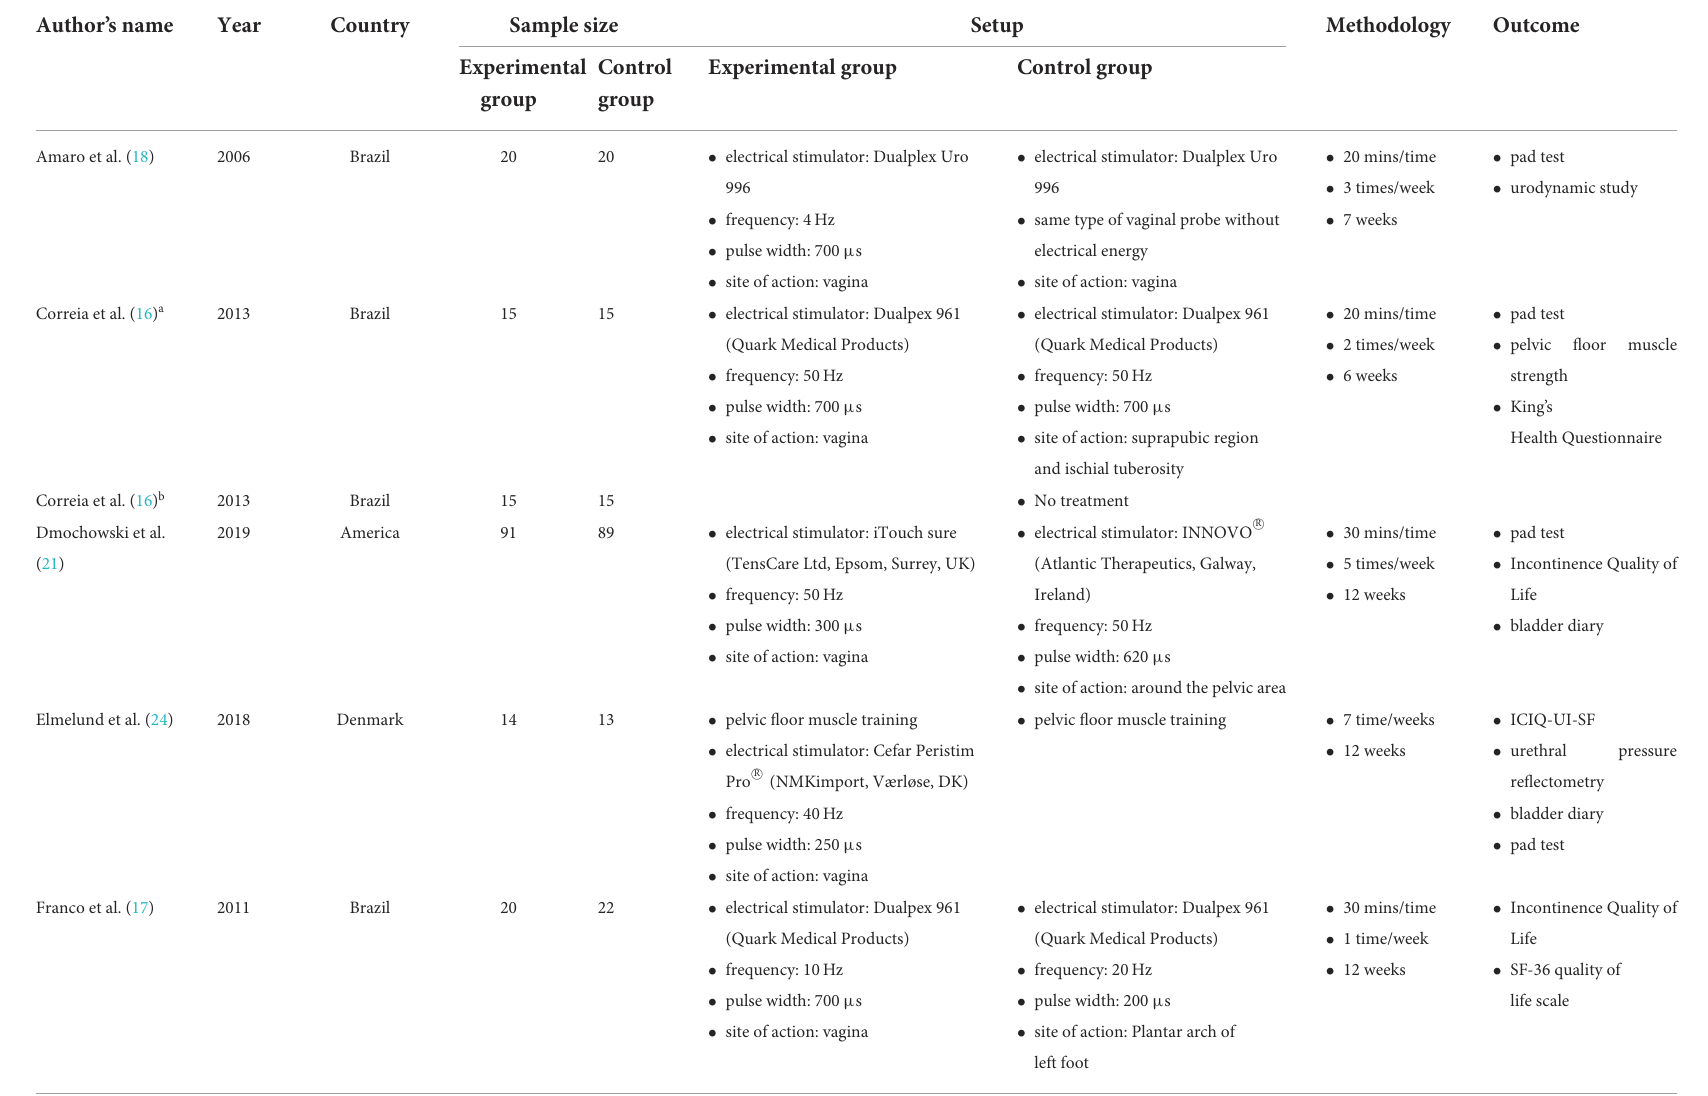
TABLE 2 Characteristics of all the